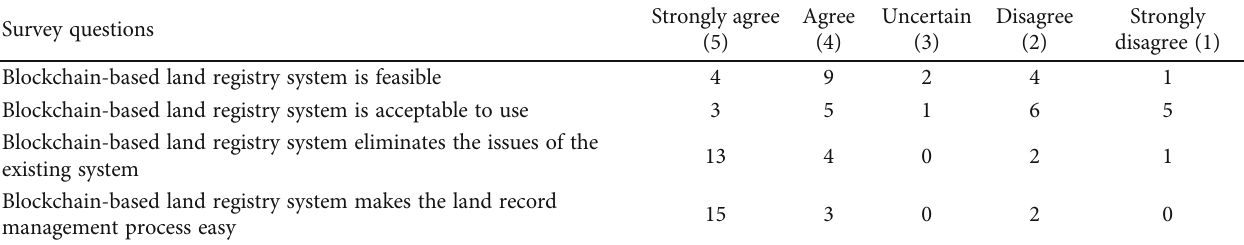
Table 2: The participant ’ s response and experience of using the proposed framework ’ s PoC.